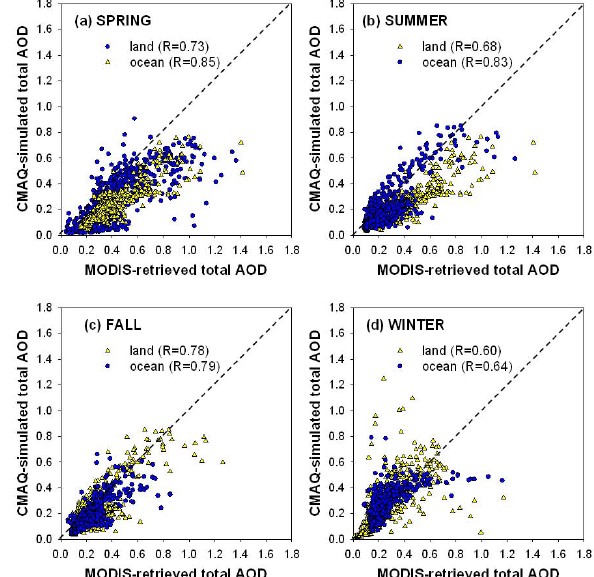
Fig. 5. Scatter plots between the CMAQ-simulated and MODIS- retrieved AODs for four seasons, 2006, over East Asia. Blue circles and yellow triangles indicate CMAQ-simulated AODs over ocean and land, respectively: (a) spring, (b) summer, (c) fall and (d) win-